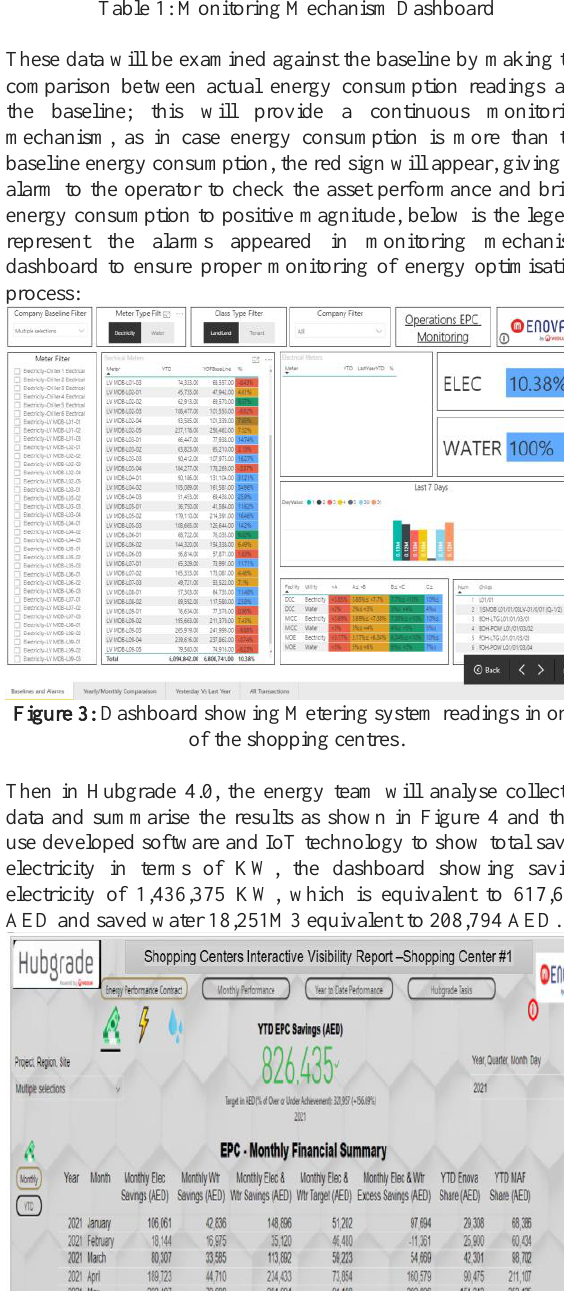
Table 1: Monitoring Mechanism Dashboard